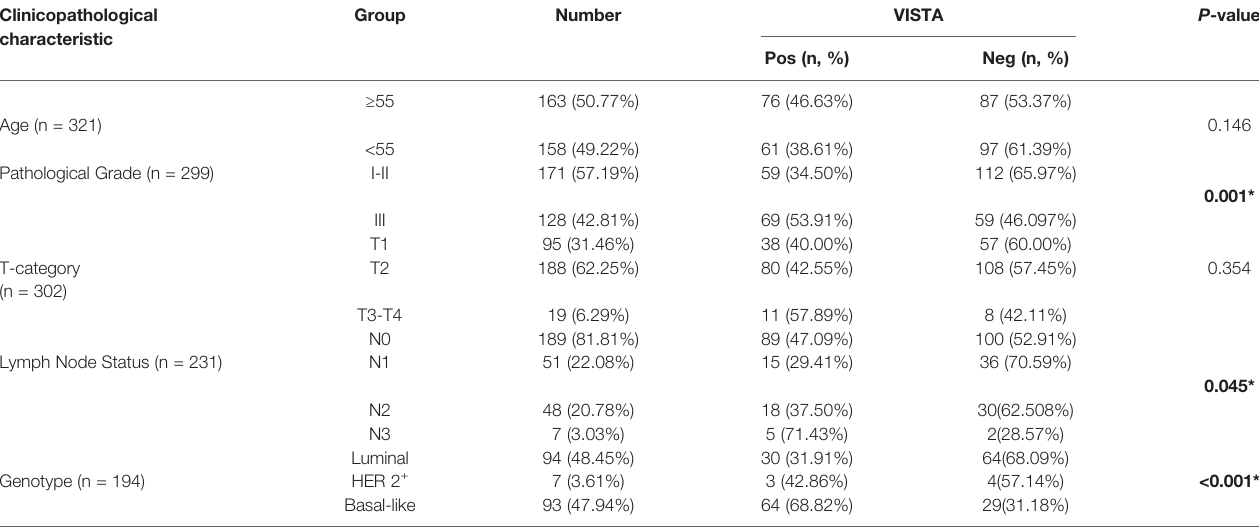
TABLE 1 | Expression of VISTA in breast cancer subpopulations with different clinicopathological characteristics. Clinicopathological characteristic